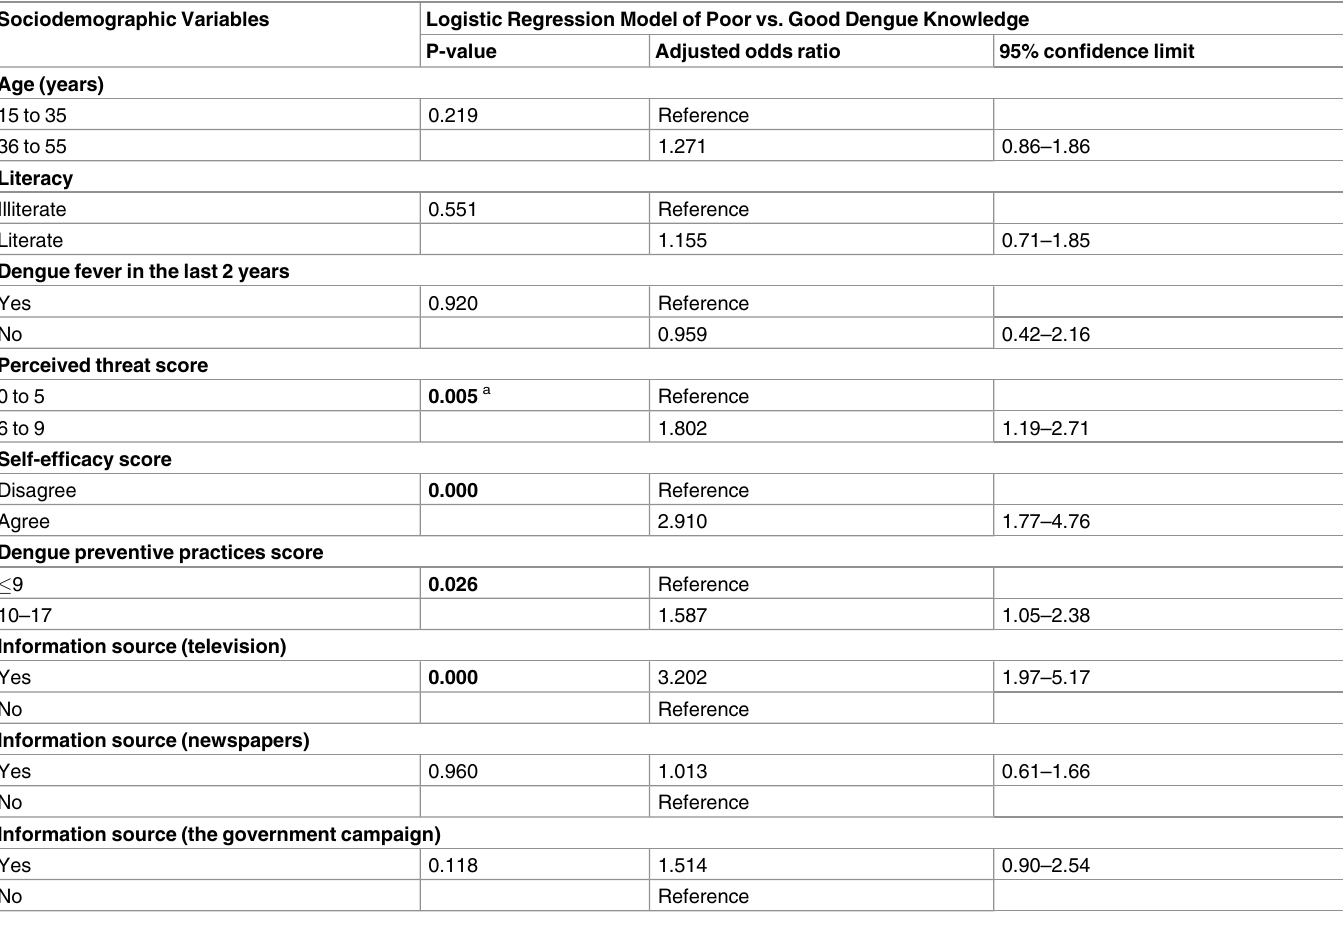
Table 3. Multivariate Logistic Regression Analysis of Variables Associated with Dengue